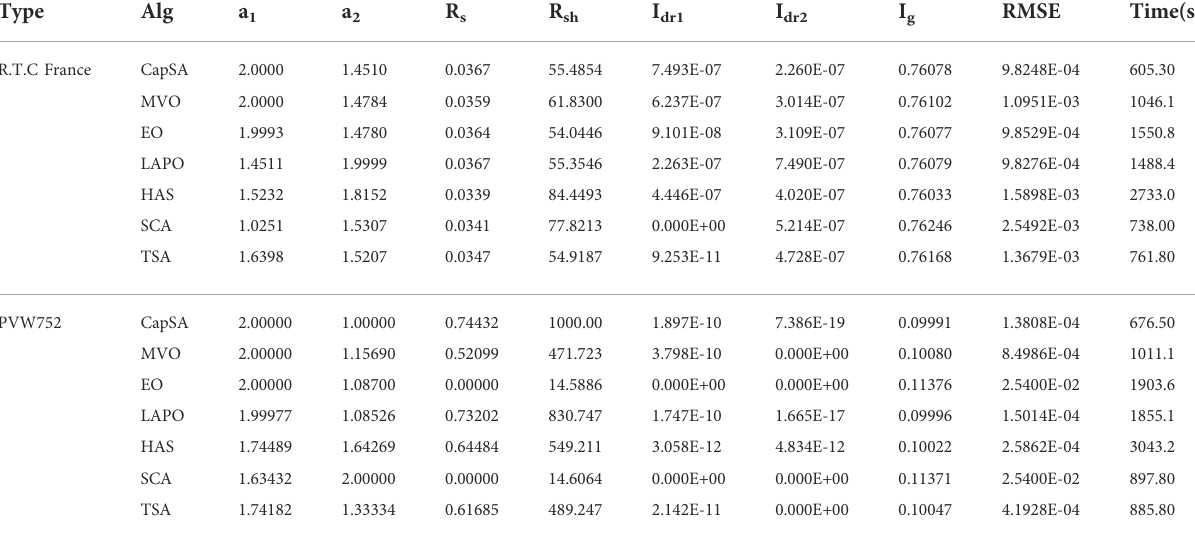
TABLE 3 DDM optimal parameters of R.T.C France and PVW752 PV cells.